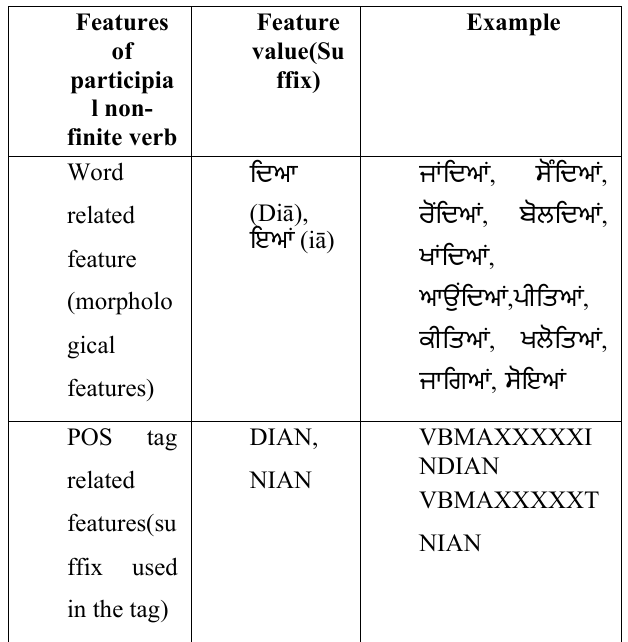
Algorithm used : Clause boundary identification of non- predicate bound participial